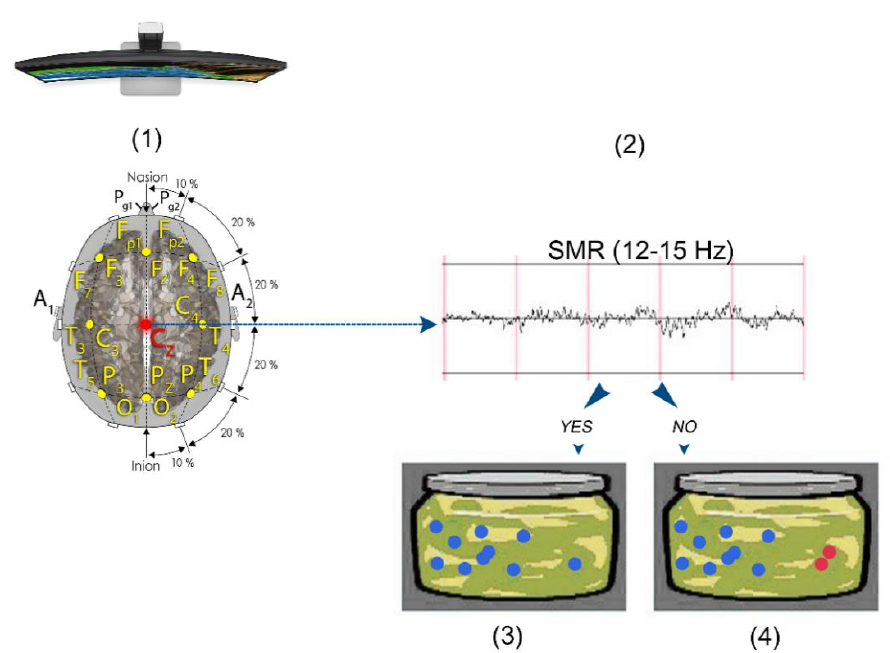
Figure 2. The subject is placed in front of a screen where the imposed videogame is projected, and their EEG activity is recorded ( 1 ). Their SMR is calculated in real time ( 2 ). If their SMR goes above the configured threshold, then new balls appear in the jar ( 3 ); if they do not get their SMR above the threshold or it falls below the threshold, then the new balls stop appearing and the ones they got before turn red and start disappearing ( 4 ).